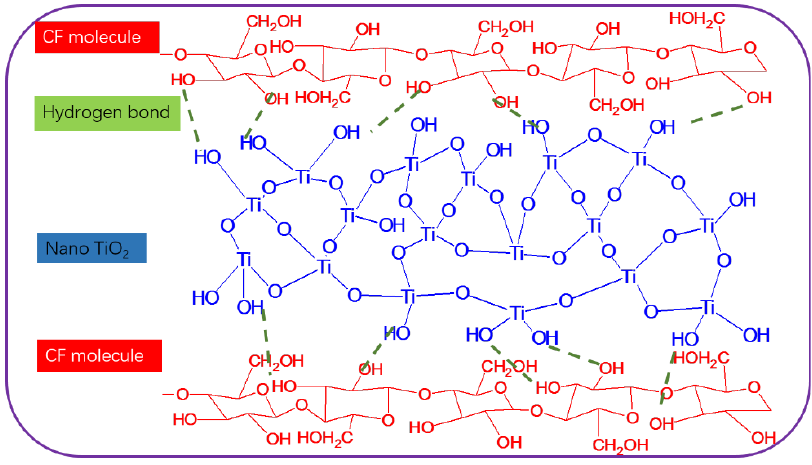
Figure 13. An illustration of the modification in SCCO 2 .